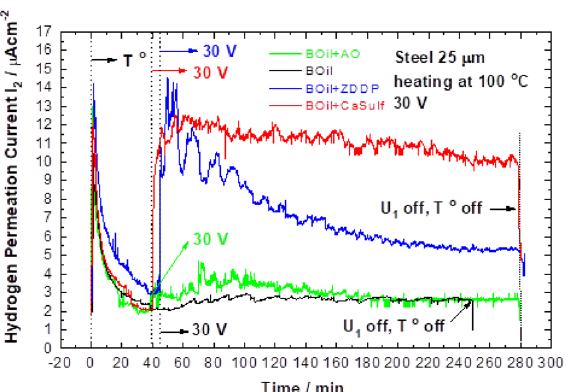
Figure 4. Comparison of transients, recorded under voltage of 30 V and upon heating at 100 °C with BOil and the compositions BOil + AO; BOil + ZDDP or BOil +